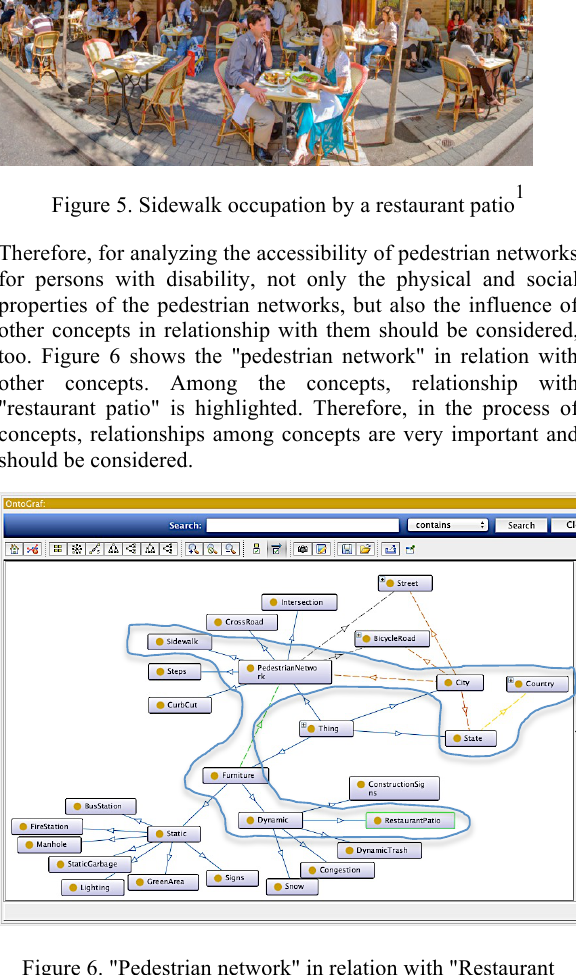
Figure 6. "Pedestrian network" in relation with